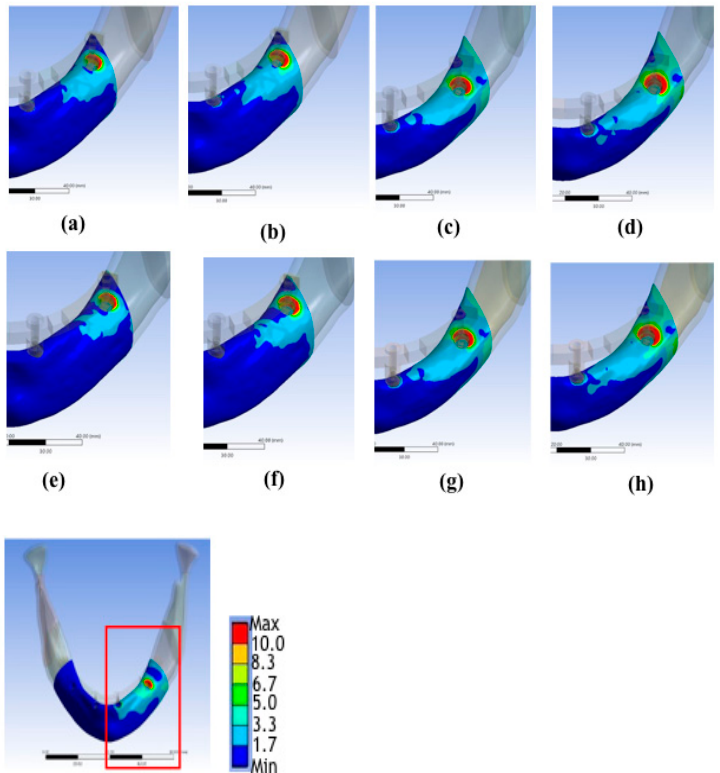
Figure 4. Distributions of von Mises stresses in the cortical bone in ( a ) Model 1, ( b ) Model 2, ( c ) Model 3, ( d ) Model 4, ( e ) Model 5, ( f ) Model 6, ( g ) Model 7, ( h ) Model 8. Table 2. The peak values of von Mises stresses located on fixture of the implant as well as surrounding cortical bone around the implant at different loading conditions. Loading Implant Location of the Atrophy Trabecular bone condition A length peak stress (MPa)